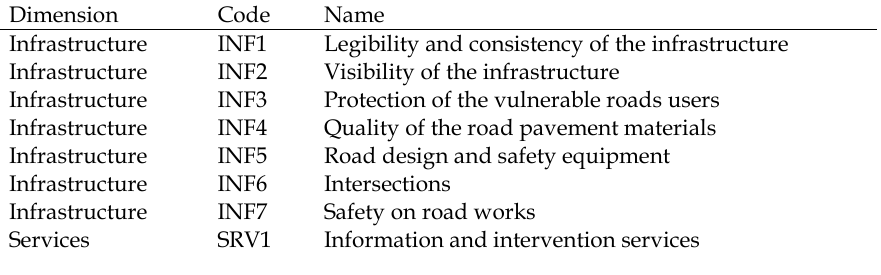
Table 1. Topics related to the road safety criteria